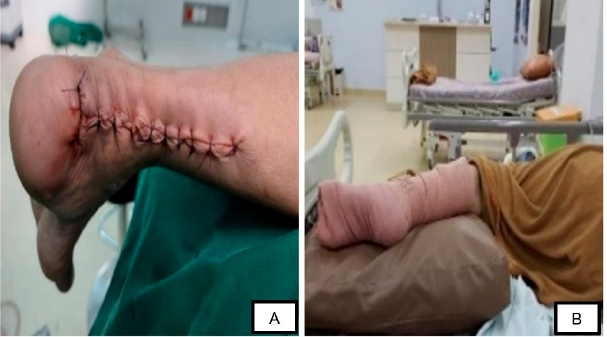
Figure 3. FHL tendon transfer and calcaneal spur reduction. ( A ) Debridement and Haglund’s de- formity detection, ( B ) identification, ( C ) FHL tendon measurement, ( D ) harvesting, ( E ) augmenta- tion, ( F ) fixation procedures, ( G ) extracted calcaneal spur.